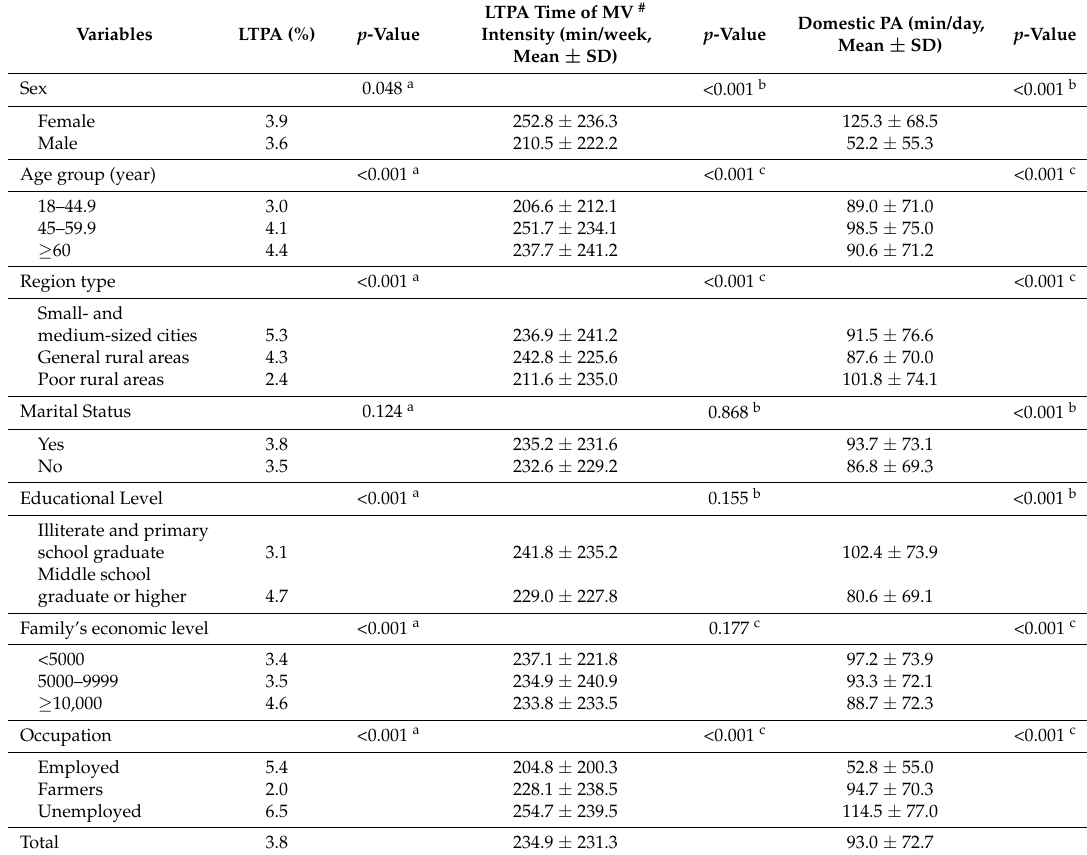
Table 5. The leisure-time physical activity (LTPA) * participation rate, LTPA time of those who had LTPA and domestic physical activity (PA) time of rural Chinese